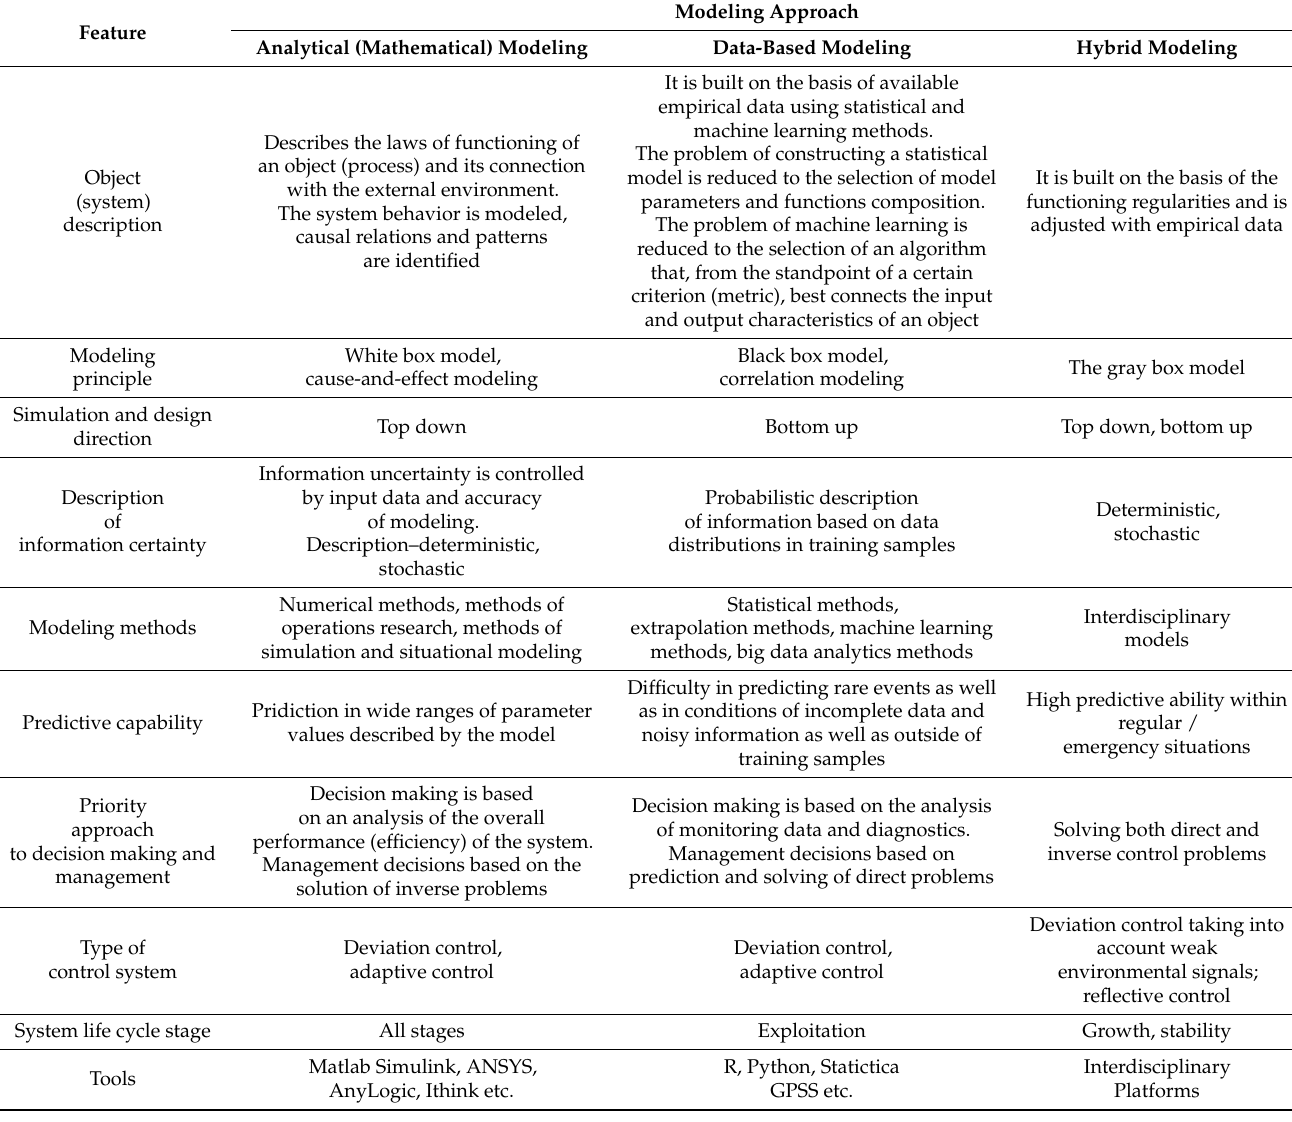
Table 1. Comparative analysis of causality models (designed on the basis of the author’s research